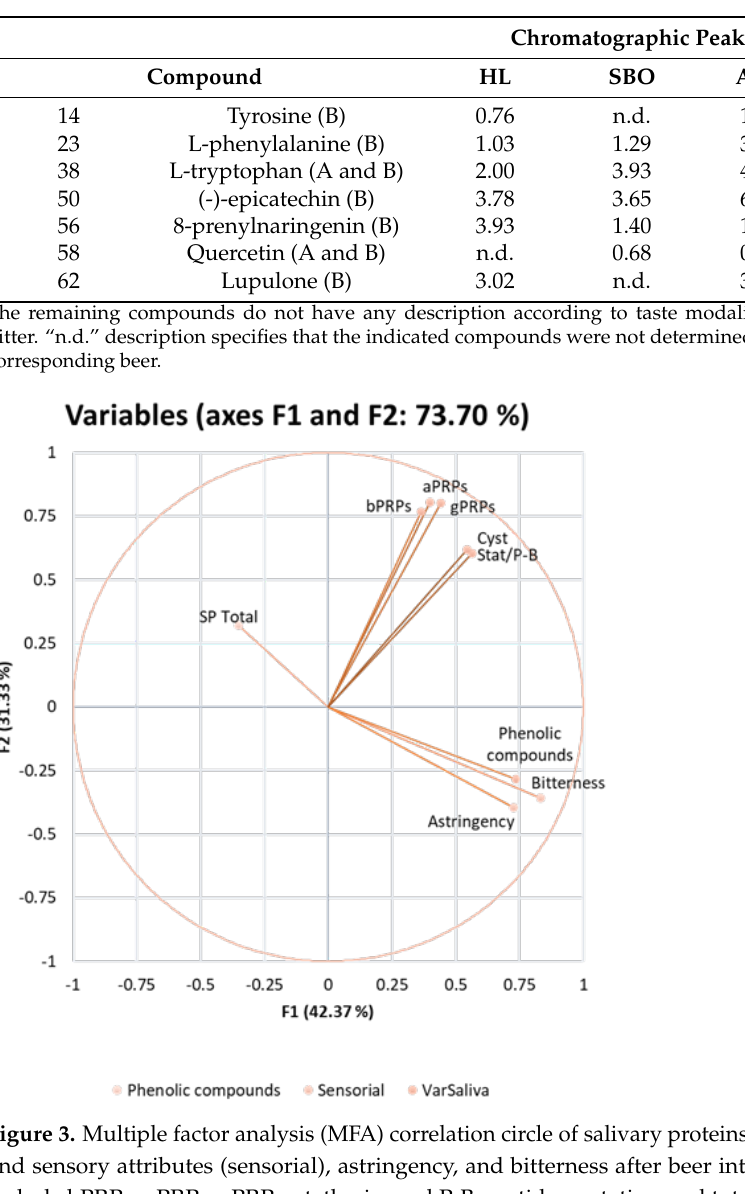
Table 5. Beer compounds’ variability within the studied beers. The peak area value was determined by the integration of each corresponding compound peak in each beer in the TIC chromatogram. (A) Astringent and (B) bitter attributes.